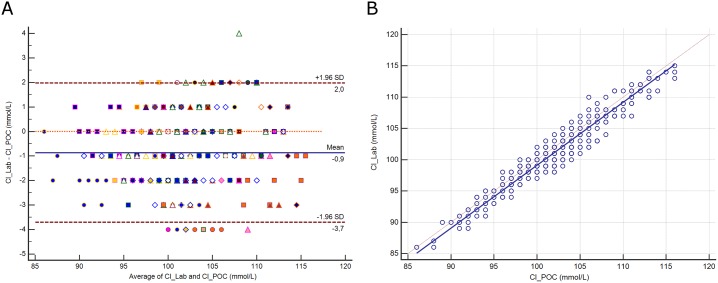
3A. Bland-Altman plot showing the difference versus the average of chloride (Cl) measured by the central Lab analyzer and by the POC Siemens RAPIDPoint 500 blood gas system. Bias, upper and lower limits of agreement (±1.96 SD) are represented. The red dotted line indicates equality (difference = 0). There is one marker for each patient. 3B. Scatter diagram showing Deming regression analysis for chloride (Cl) measured by the central Lab analyzer and by the POC Siemens RAPIDPoint 500 blood gas system. The regression line (solid line) and the identity line (x = y, dotted line) are represented.